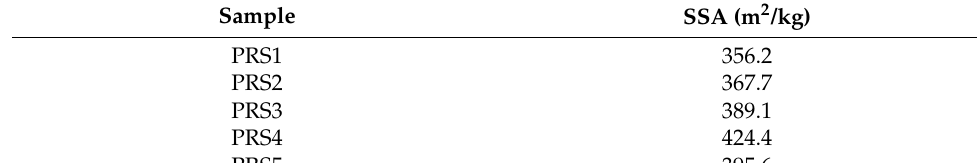
Table 5. Pore structure changes of reconstructed steel slag before and after SiC foaming.